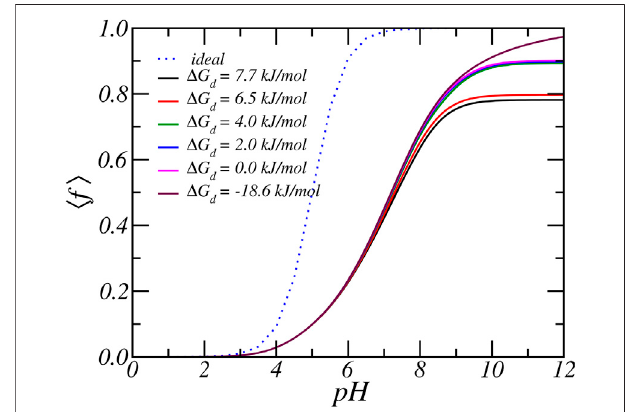
FIGURE5| Theaveragedegreeofprotonation,asafunctionofreservoir pH for various carboxylate-Rb dissociation free energies. Form top to bottom the dissociation free energy, or equivalent the binding free energy decreases. The reservoir has a RbCl concentration of [RbCl] = 50 mM